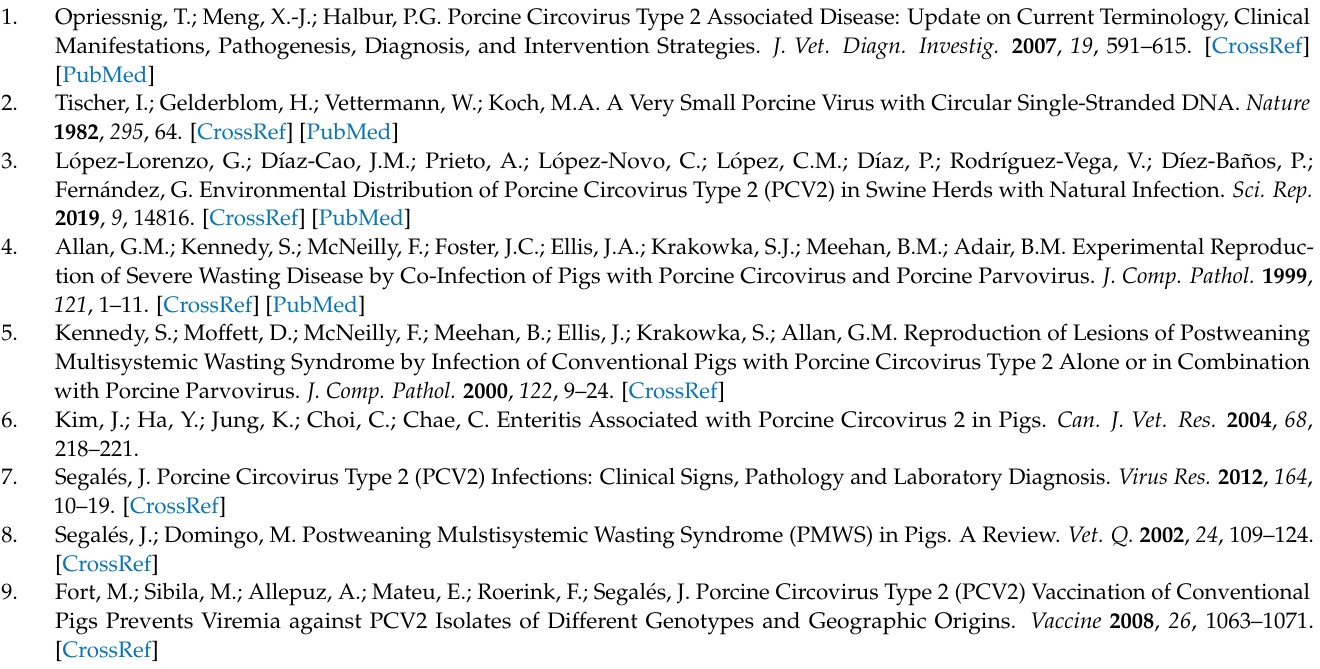
reaction; Figure S2: Comparison of anti-PCV2 peptide-specific IgGs between two groups of pigs at different ages; Figure S3: Location of amino acid residues of designed peptide (P64) and critical binding residues on the single capsid protein of